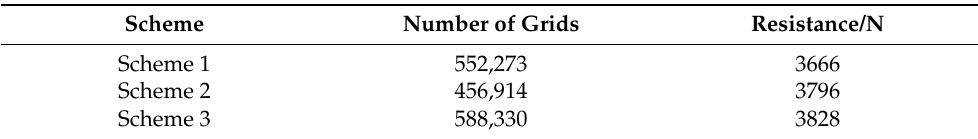
Table 4. Resistance under different grid